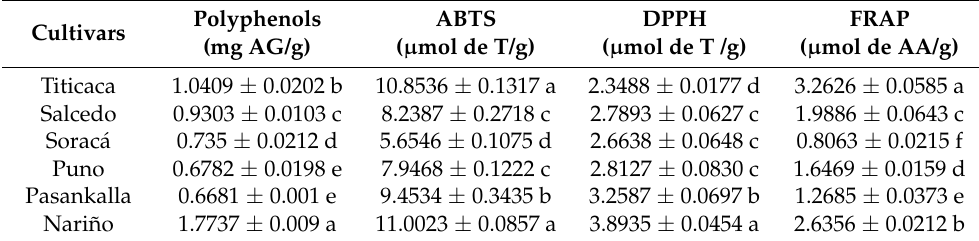
Table 5. Phenolic composition and antioxidant activity in quinoa cultivars in Colombia. Cultivars